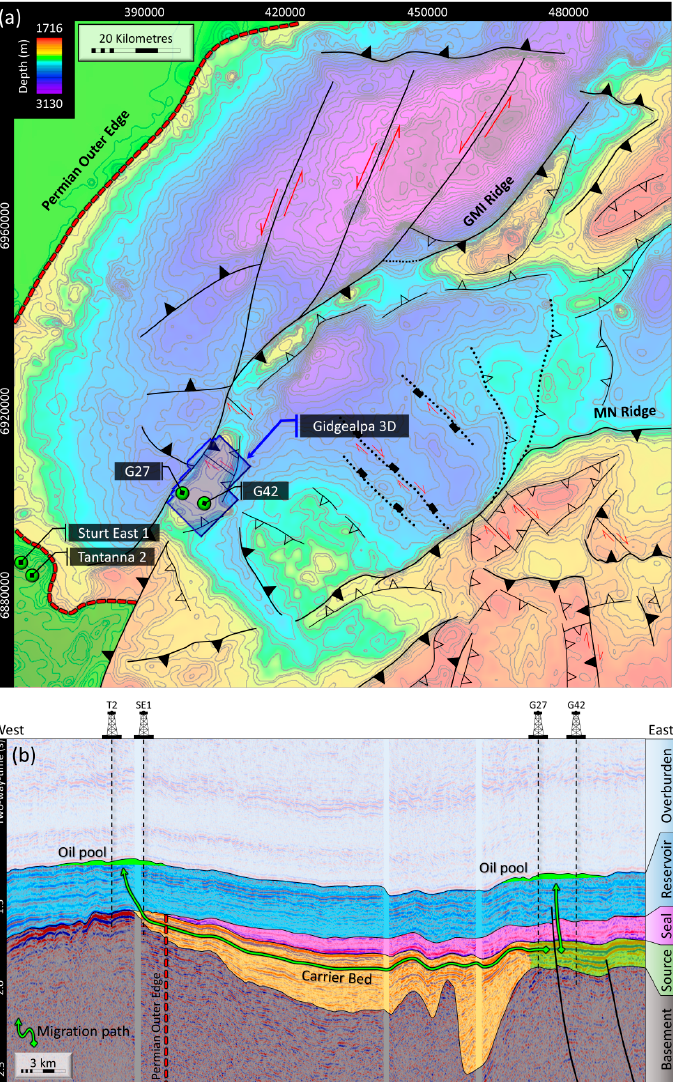
Figure 3. Structural interpretation of the Cooper-Eromanga Basin showing the location of wells, the Permian outer edge (where Triassic seal pinches out), and the migration of oil from source rocks to traps: ( a )—Basement fault map of the study area showing the location of the four wells used in this study. Source rock composition was obtained from the Patchawarra Formation in wells G27 and G45. The expelled oil migrated along two pathways, vertically through large basement faults and laterally through a carrier bed. The oil compositions in the Jurassic reservoir are obtained from G27 and G45 wells (vertical migration through faults), and Tantanna 2 (T1) and Sturt East 1 (SE1) (lateral migration through carrier bed). [24,49]; ( b ) showing the two migration paths from the source rock in the Gidgealpa region to the oil pools through faults and via sedimentary rocks. The Permian outer edge shows the location where Triassic seals pinch-out, allowing oil to freely migrate from the source rock to the overlying reservoir rock.